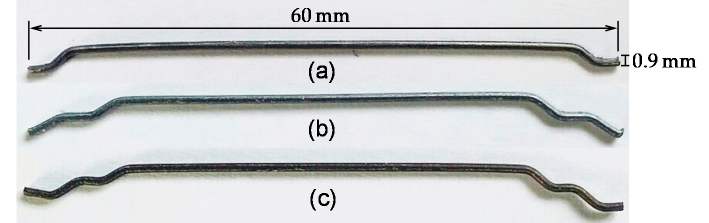
Figure 1. Pictures on ( a ) 3D hooked fiber, ( b ) 4D hooked fiber, and ( c ) 5D hooked